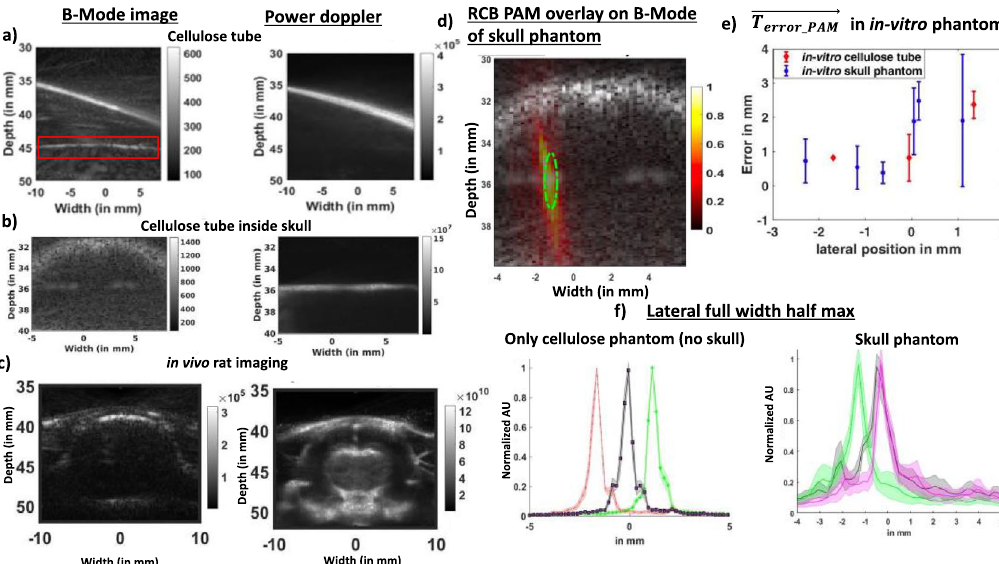
Figure 2. Targeting FUS with microbubble-enhanced power Doppler. ( a ) Using 8.9 MHz, SVD filtering of B-mode images removed stationary signals in the cellulose tube (red box highlights stationary boundary), and ( b ) similar SNR was feasible through the skull phantom. ( c ) In vivo imaging through the skull was performed at 5.2 MHz to account for skull thickness. ( d ) RCB passive acoustic map overlayed on skull phantom B-Mode image revealed regions undergoing cavitation in the skull phantom. Cavitation energy is contained within the −−−−−−→ T error green focus. ( e ) A _ PAM comparison in in vitro cellulose tube and skull phantom, each undergoing 10 trials. ( f ) The point of maximum intensity in 3 steered maps was calculated and plotted in lateral dimension for cellulose phantom with and without